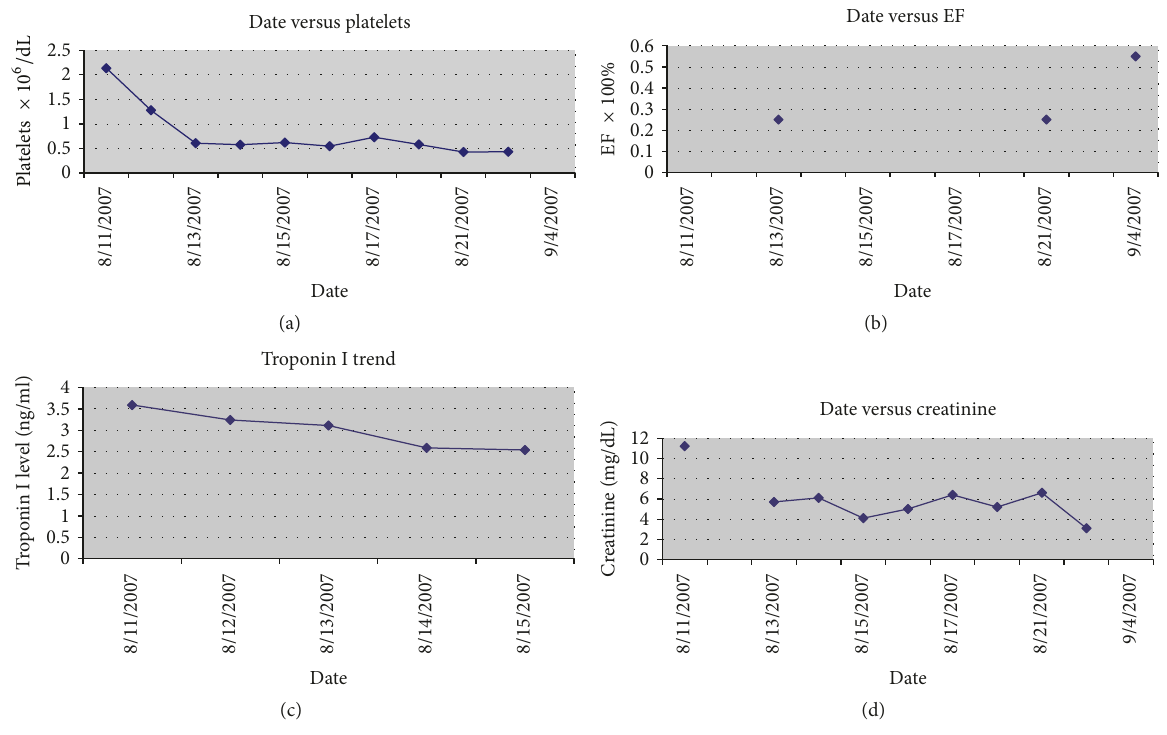
Figure 2: (a) Graph of trend of platelet count versus time for initial hospitalization for patient. (b) Graph of trend of ejection fraction (EF) versus time for initial hospitalization for patient. (c) Graph of downtrend of troponin after peak value of 33.6 ng/ml versus time for initial hospitalization for patient. (d) Graph of trend of serum creatinine versus time for initial hospitalization for patient.